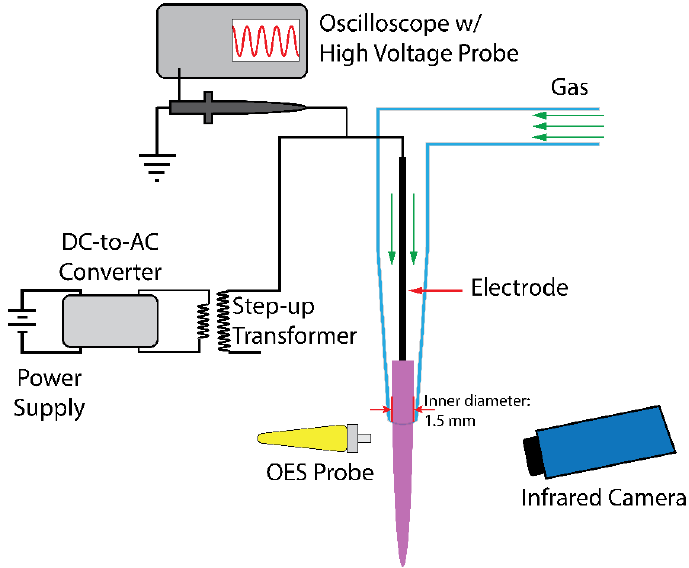
Figure 1. Schematic representation of the single electrode plasma jet